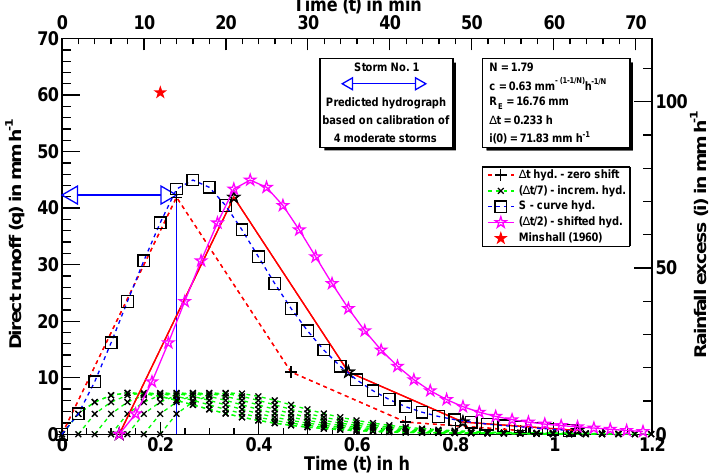
Fig. 7c. Same as Fig. 7b, superimposed by the incremental, composite or S-curve, and the time-shifted hydrographs using a computational time step of 1t /7, i.e.